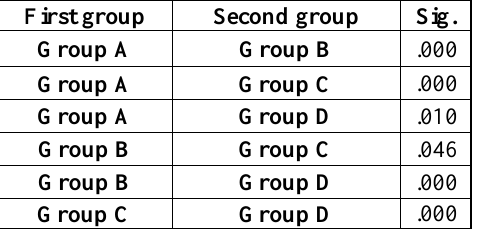
Histopathological study: